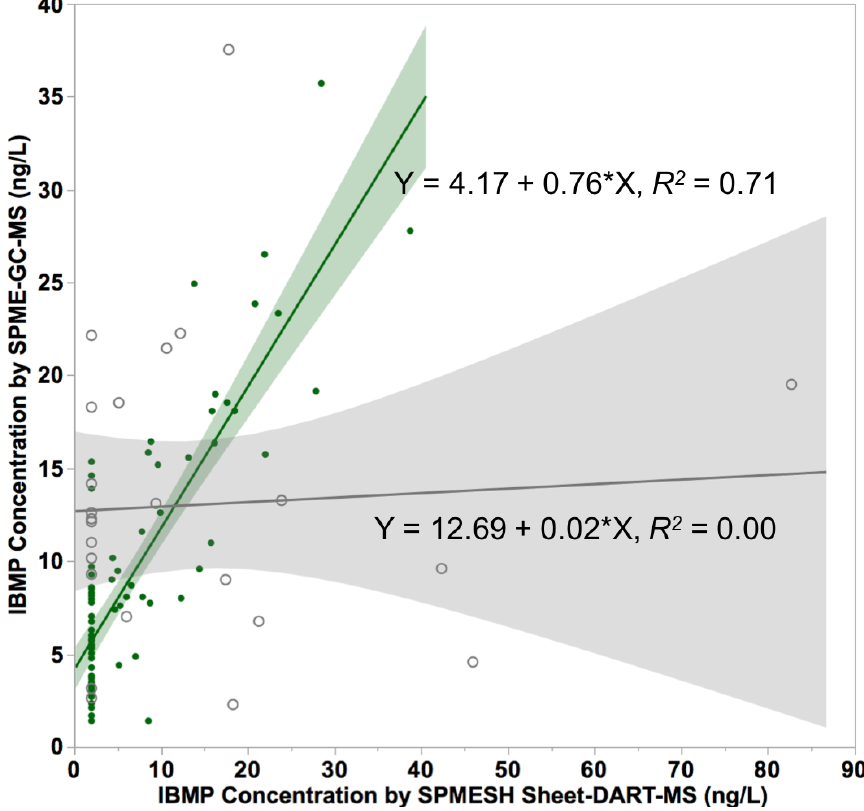
Figure 3. Initial (130 rpm, 50 °C, 30 min equilibration—gray open circles) and optimized (230 rpm, 70 °C, 1 h equilibration—green filled circles) correlation data for IBMP in Cabernet Sauvignon and Merlot grapes measured by SPMESH sheet-DART-MS, compared to SPME-GC-MS. Shaded areas represent 95% confidence intervals of the linear regression. Undetectable values were set to the square root of the limit of detection (IBMP = 2 ng/L for DART).